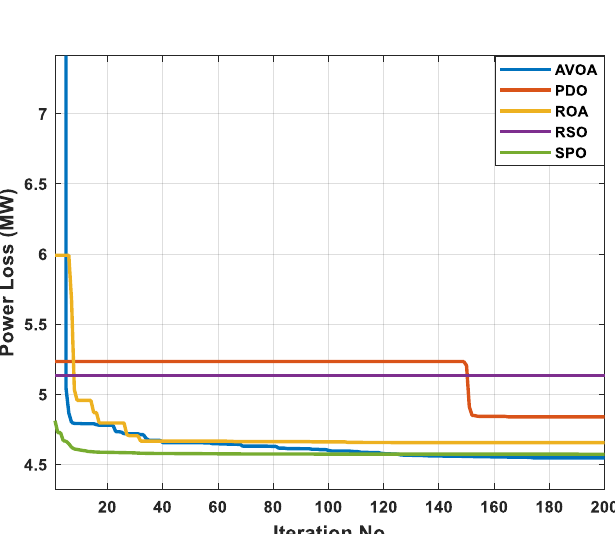
Figure 7. The AVOA convergence characteristics with the other compared methods for case 3.